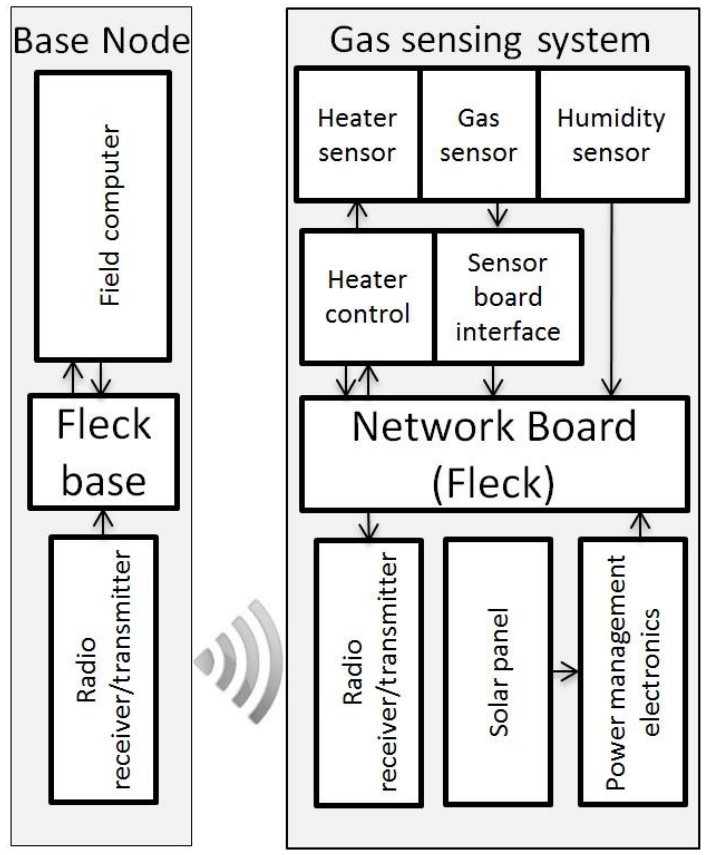
Figure 2. Wireless sensor node and base node